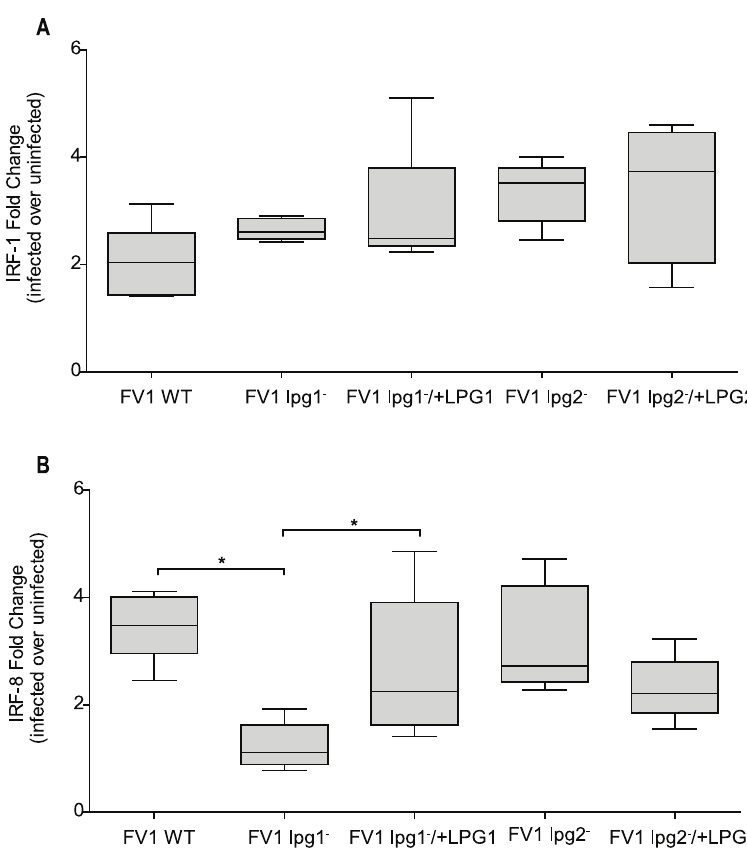
Fig 7. The lpg1 − mutant affects IL12 associated gene regulator IRF8 , and not IRF1 . Human DCs were infected with L . major FV1 parasites: L . major FV1 (WT) , LPG null mutant (FV1 lpg1 − ), LPG add back (FV1 lpg1 − /+ LPG1 ), PG null mutant (FV1 lpg2 − ), or PG add back (FV1 lpg2 − /+ LPG2 ). At 8 hrs post infection, ( A ) IRF8 (n = 3 donors) and ( B ) IRF1 (n = 5 donors) expression was measured by qRT-PCR. Fold changes were calculated using the ΔΔ C T method and are represented as fold change over uninfected samples. Box plots display the median value (line), the interquartile range (box), and Tukey whiskers encompassing data within 1.5 fold of the interquartile range. * Statistical significance (p < 0.05). All values were significantly greater than